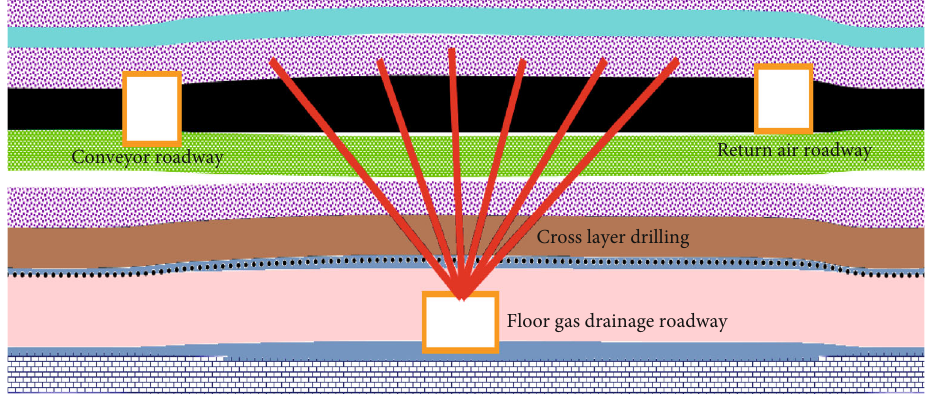
Figure 3: Schematic diagram of the perforating drill hole.